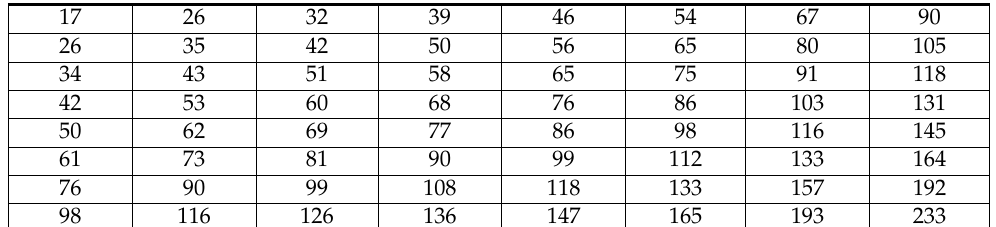
Table 3. A custom quantization table proposed in [48] for the JPEG algorithm without chroma subsampling.